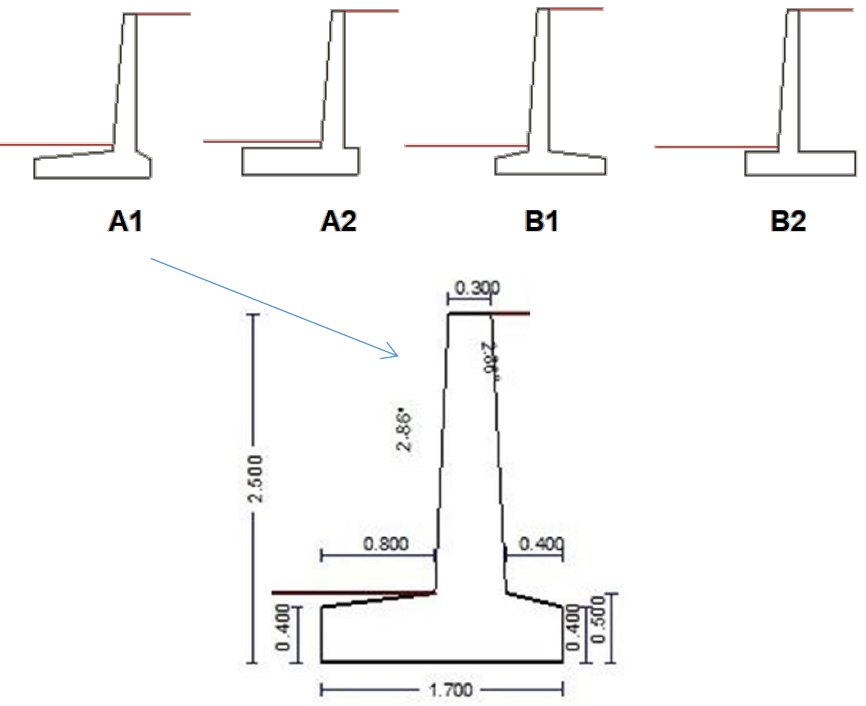
Figure 3. Reinforced concrete retaining walls examined in this study (types A1, A2, B1, and B2) and a typical example of a 2.5-m-height A1-type retaining wall (dimensions in meters).